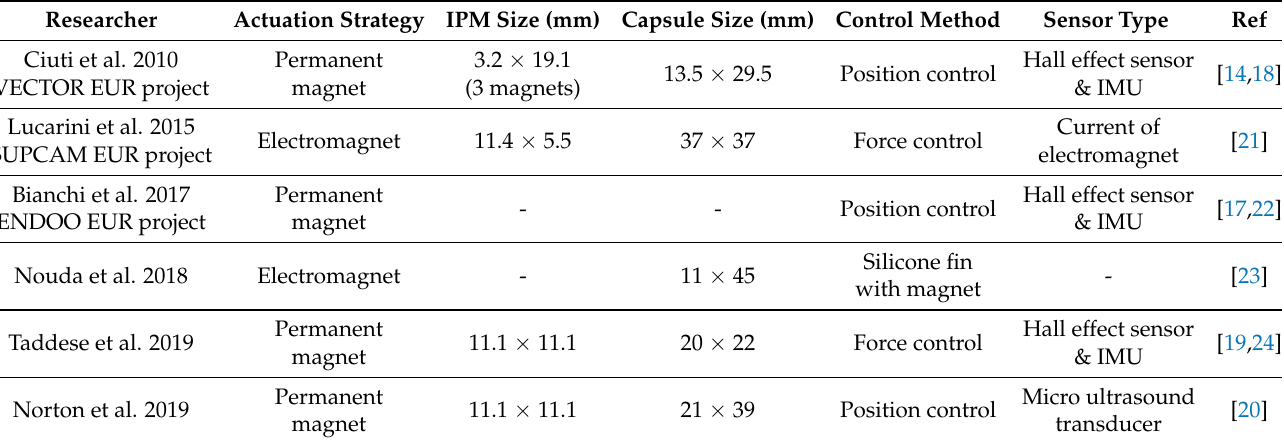
Table 1. Comparison of current magnetically-guided capsule